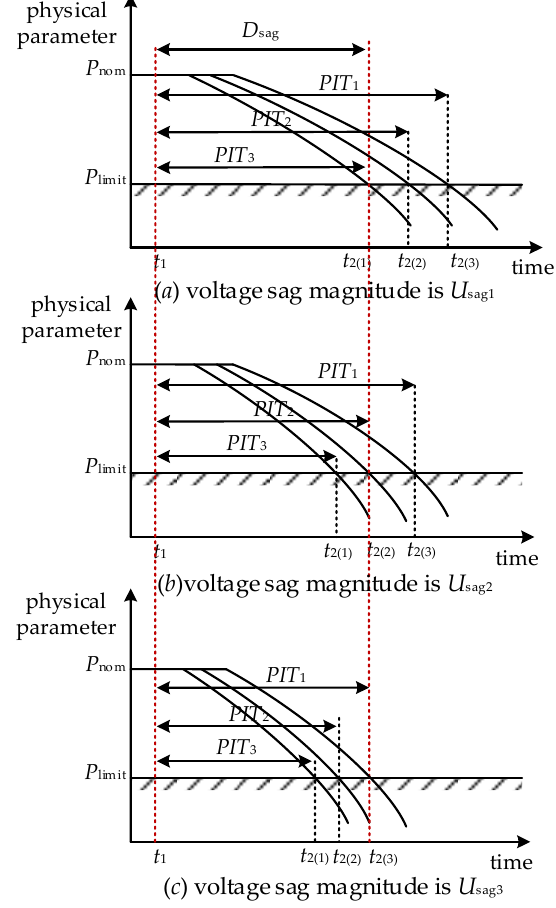
Figure 4. Response characteristic of process to voltage sag.